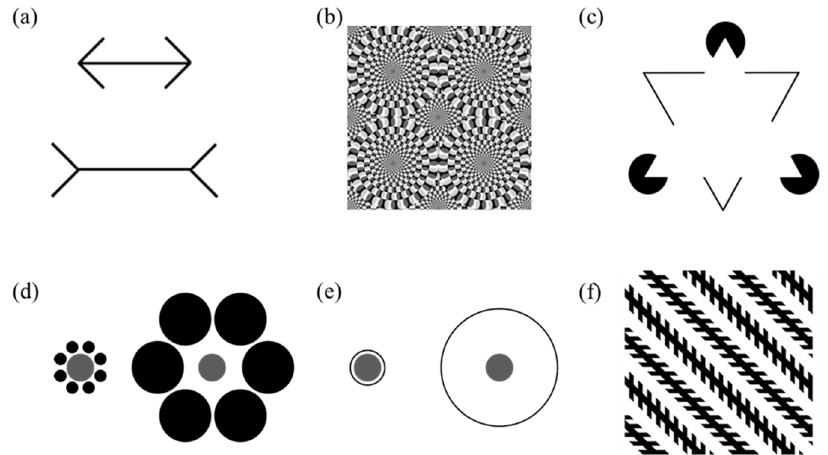
Figure 1. Müller-Lyer illusion ( a ), Rotating Snake illusion ( b ), Kanizsa’s triangle ( c ), Ebbinghaus illusion ( d ), Delboeuf illusion ( e ) and Zöllner illusion ( f ).